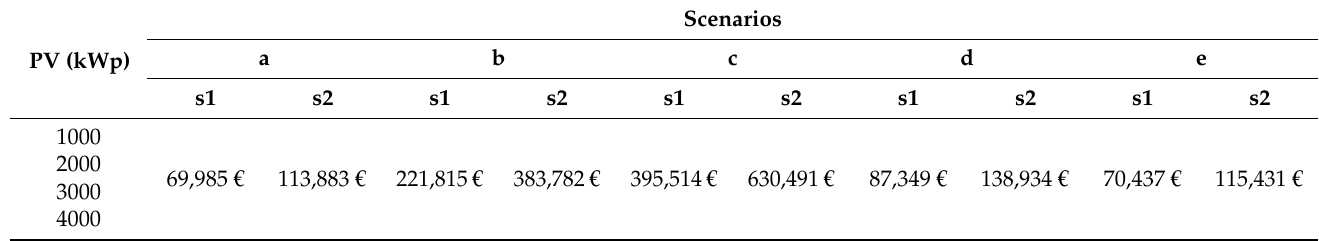
Table 4. Contribution expressed in monetary value of the proposed charging strategy compared to uncoordinated charging strategy.